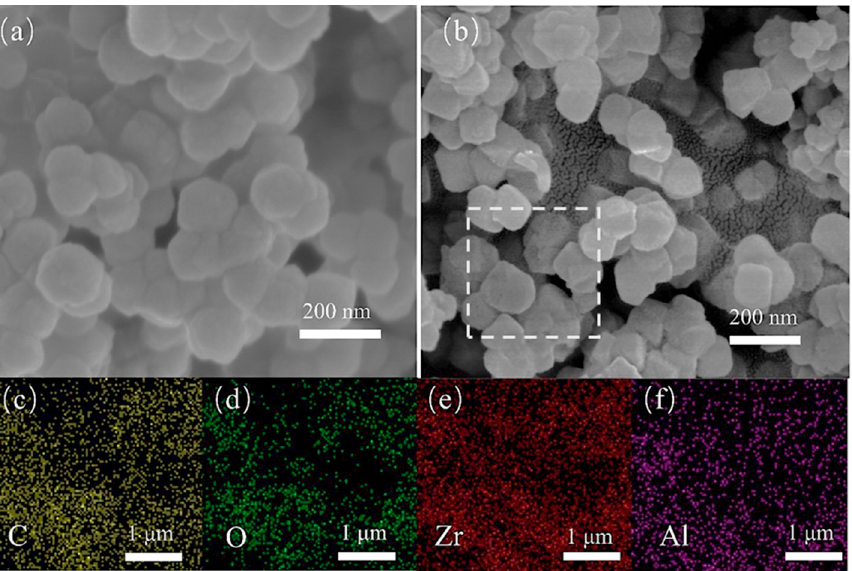
Figure 2. SEM images of UiO-66 ( a ) and Al 0.3 Zr 0.7 -UiO-66 ( b ); and EDS mappings of the portion selected: distribution of C ( c ), O ( d ), Zr ( e ), and Al ( f ). Similar FT-IR spectra of UiO-66 and Al 0.3 Zr 0.7 -UiO-66 were observed, as shown in Figure 3. The two obvious bands, approximately 1399 and 1585 cm − 1 , could be ascribed to the symmetric and asymmetric stretch vibrations of the O=C-O-group, as confirmed by their presence in the framework. The band of approximately 1100 cm − 1 belonged to Zr-O vibration. The vibration bands, approximately 745 cm − 1 and 666 cm − 1 , are characteristic bands of the O-H and C-H vibrations in the H 2 BDC ligand [24,30]. The peak at 590 cm − 1 in Al 0.3 Zr 0.7 -UiO-66 could be assigned to the Al-O stretching vibration [31–33], which also indicates that Al was involved in the formation of Al x Zr (1 − x) -UiO-66 MOF.